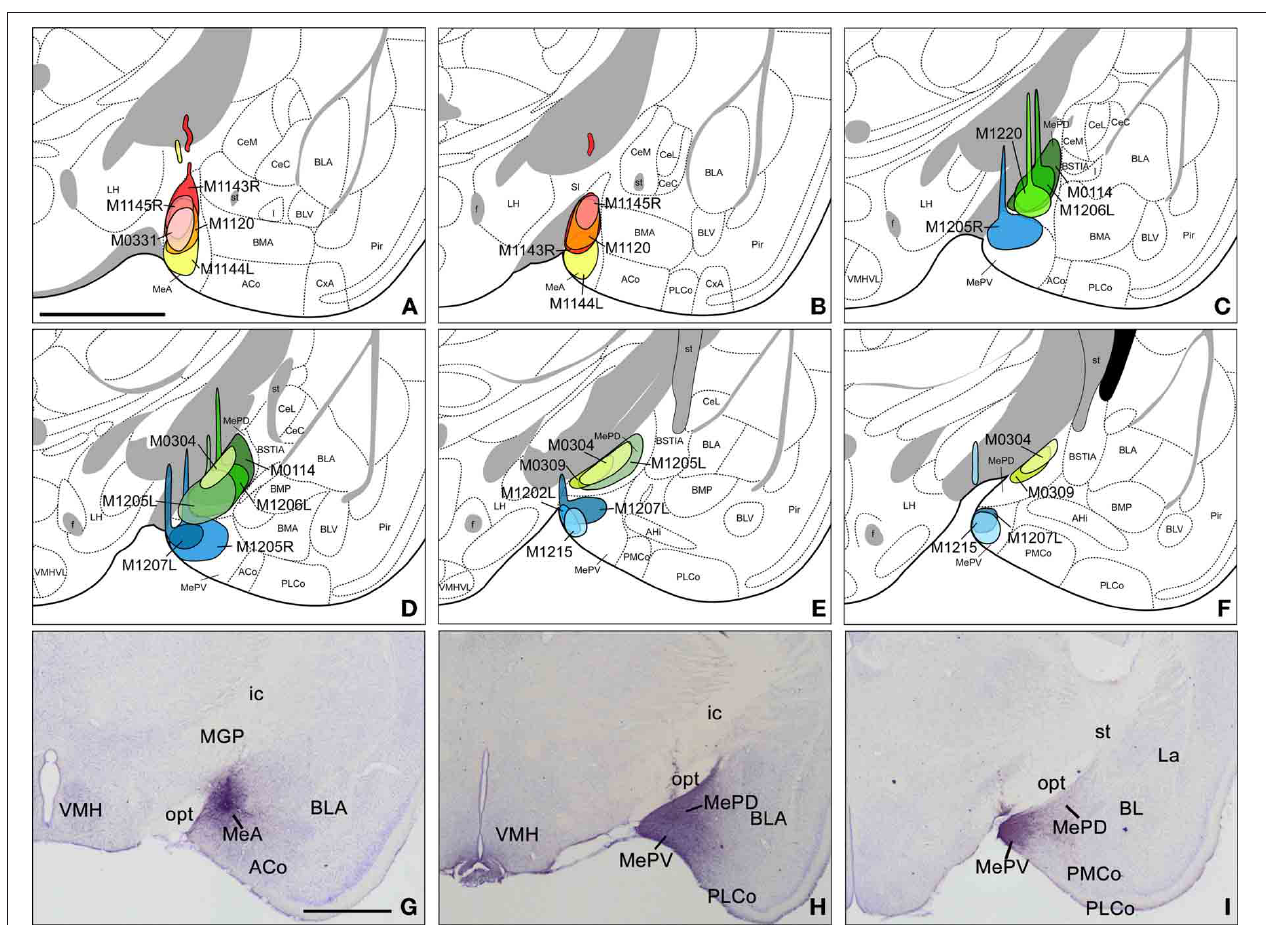
FIGURE 1 | Injection sites in the anterior, posterodorsal, and posteroventral subdivisions of the medial amygdaloid nucleus. (A–F) Schematic drawings representing the extent of the tracer injections in the anterior medial amygdaloid nucleus (MeA), the posterodorsal medial amygdaloid nucleus (MePD), and the posteroventral medial amygdaloid nucleus (MePV). MeA injections are represented in warm colors ( Figures 1A and B ), MePD in green and MePV in blue ( Figures 1C–F ). Colored areas